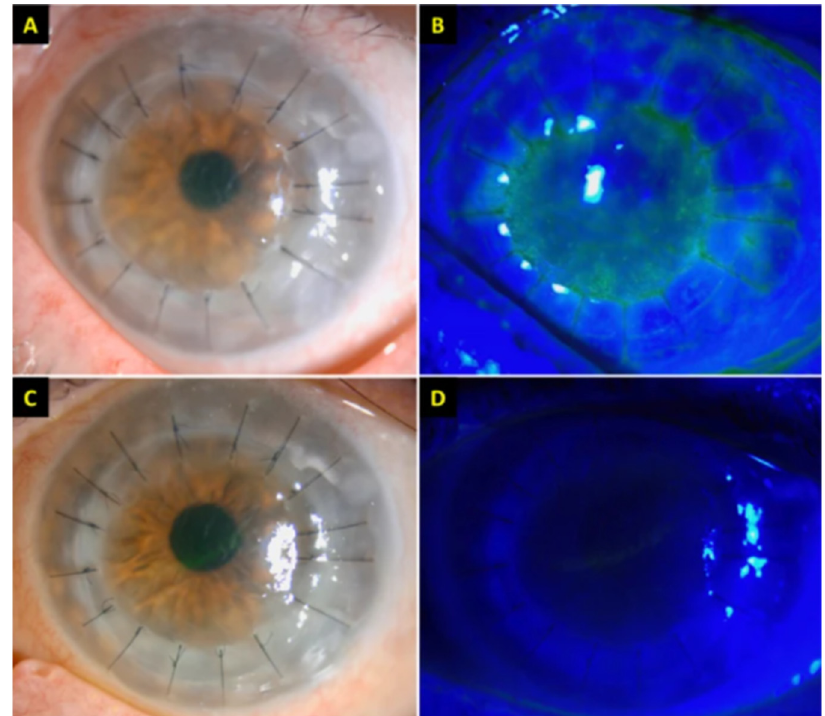
Figure 3. ( A , B ) Slit-lamp photography demonstrating conjunctival hyperemia, corneal graft haze, diffuse corneal epithelial, and stromal oedema (within the graft), Descemet’s folds, scattered keratic precipitates (KPs), and 1+ cells in anterior chamber. An unusual distribution of fluorescein staining with coarse punctate epitheliopathy over the corneal graft was observed. The central corneal thickness (CCT) was 730 µ m. ( C , D ) At 3-week post treatment, the corneal graft rejection was successfully treated with considerable improvement in the graft transparency, reduction in epithelial and stromal oedema, and resolution of epitheliopathy and anterior chamber inflammation. The best-corrected visual acuity improved to 6/12, with a CCT of 609 µ m. Adapted from Rallis, K.I.; Ting, D.S.J.; Said, D.G.; et al. Corneal graft rejection following COVID-19 vaccine. Eye (2021).